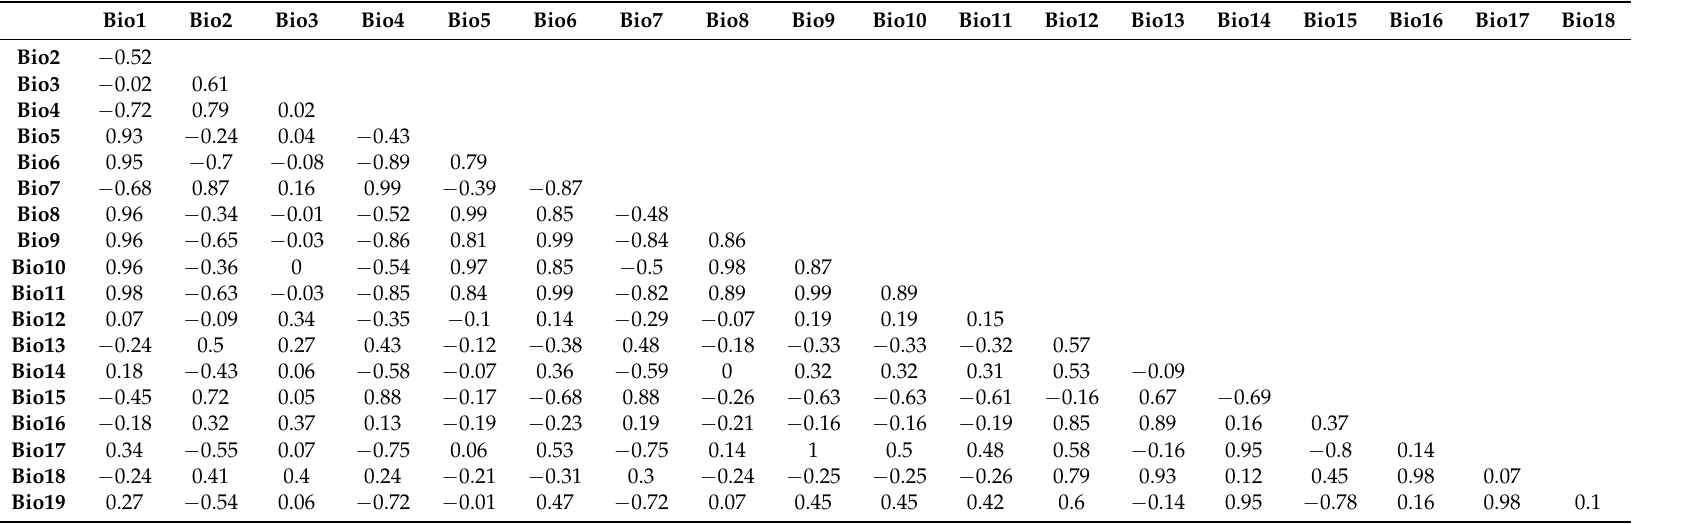
Table A1. The results of Pearson’s correlation analyses between bioclimatic